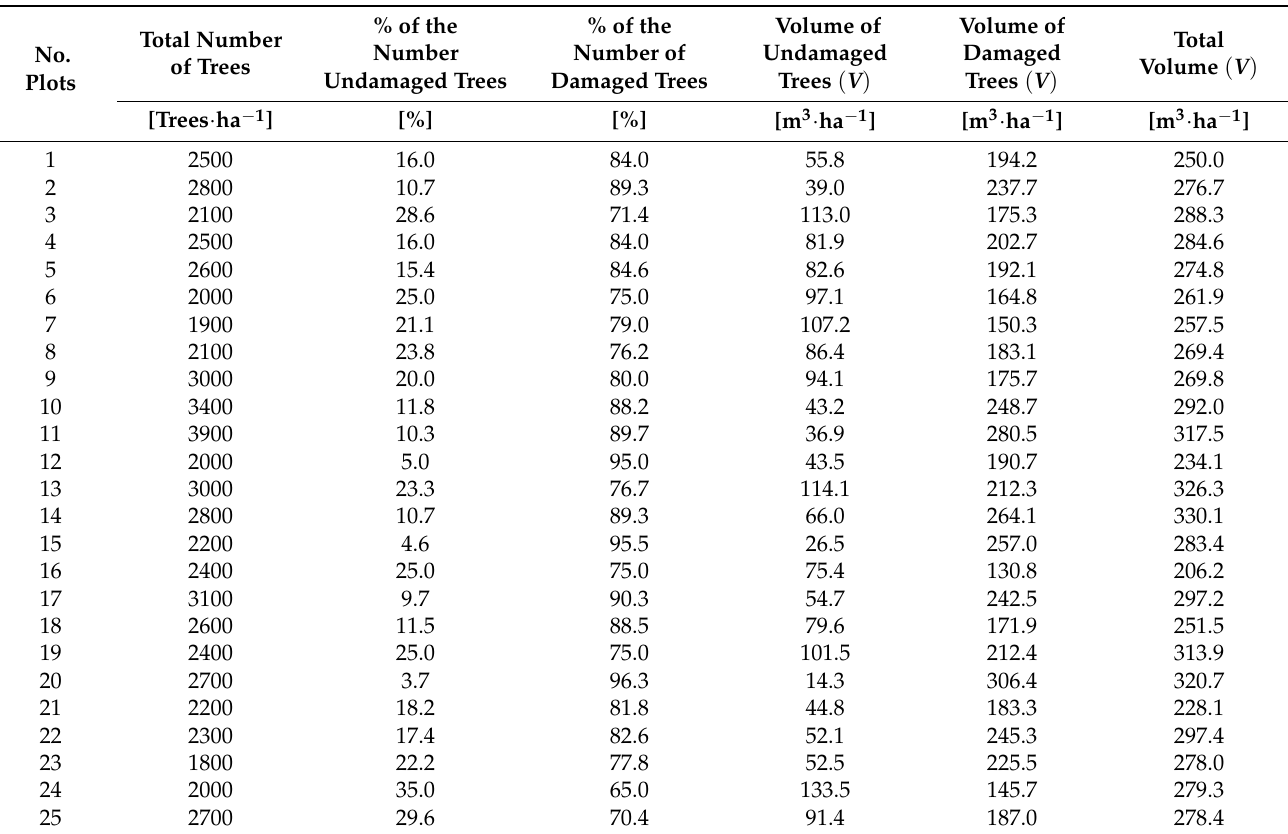
Table 3. The percentage shares of damaged and undamaged trees along with their